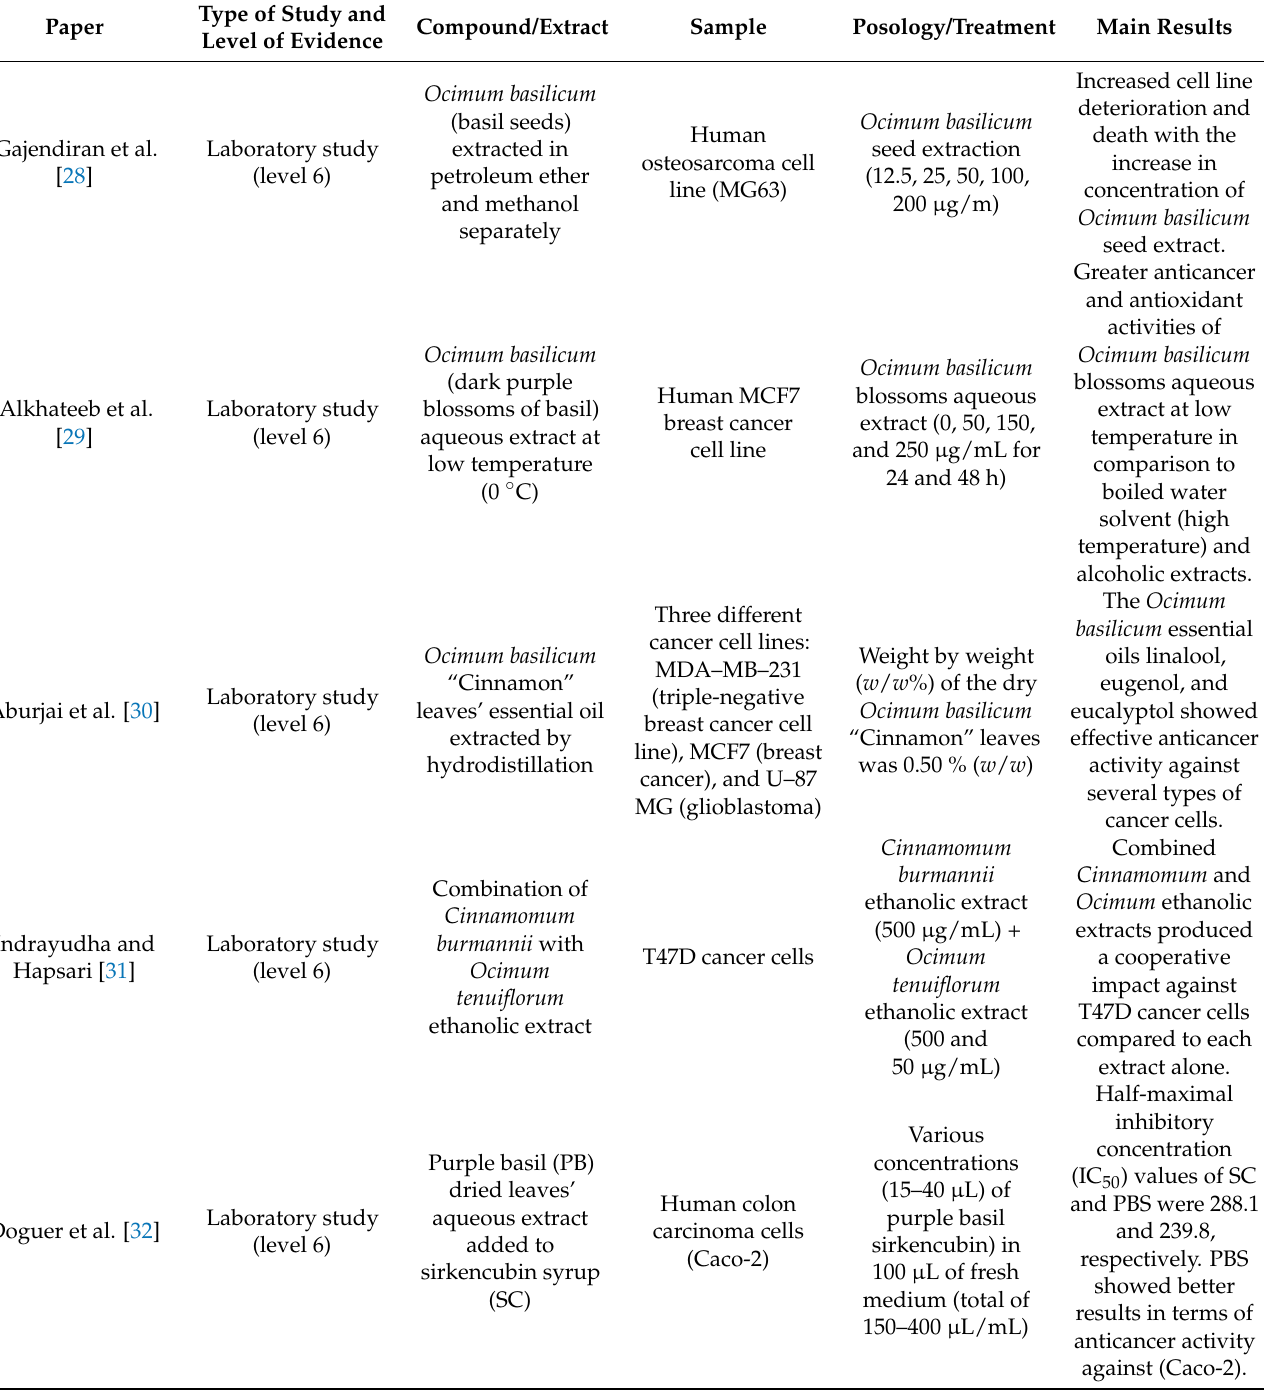
Table 2. Anticarcinogenic effects of basil extracts in laboratory in vitro